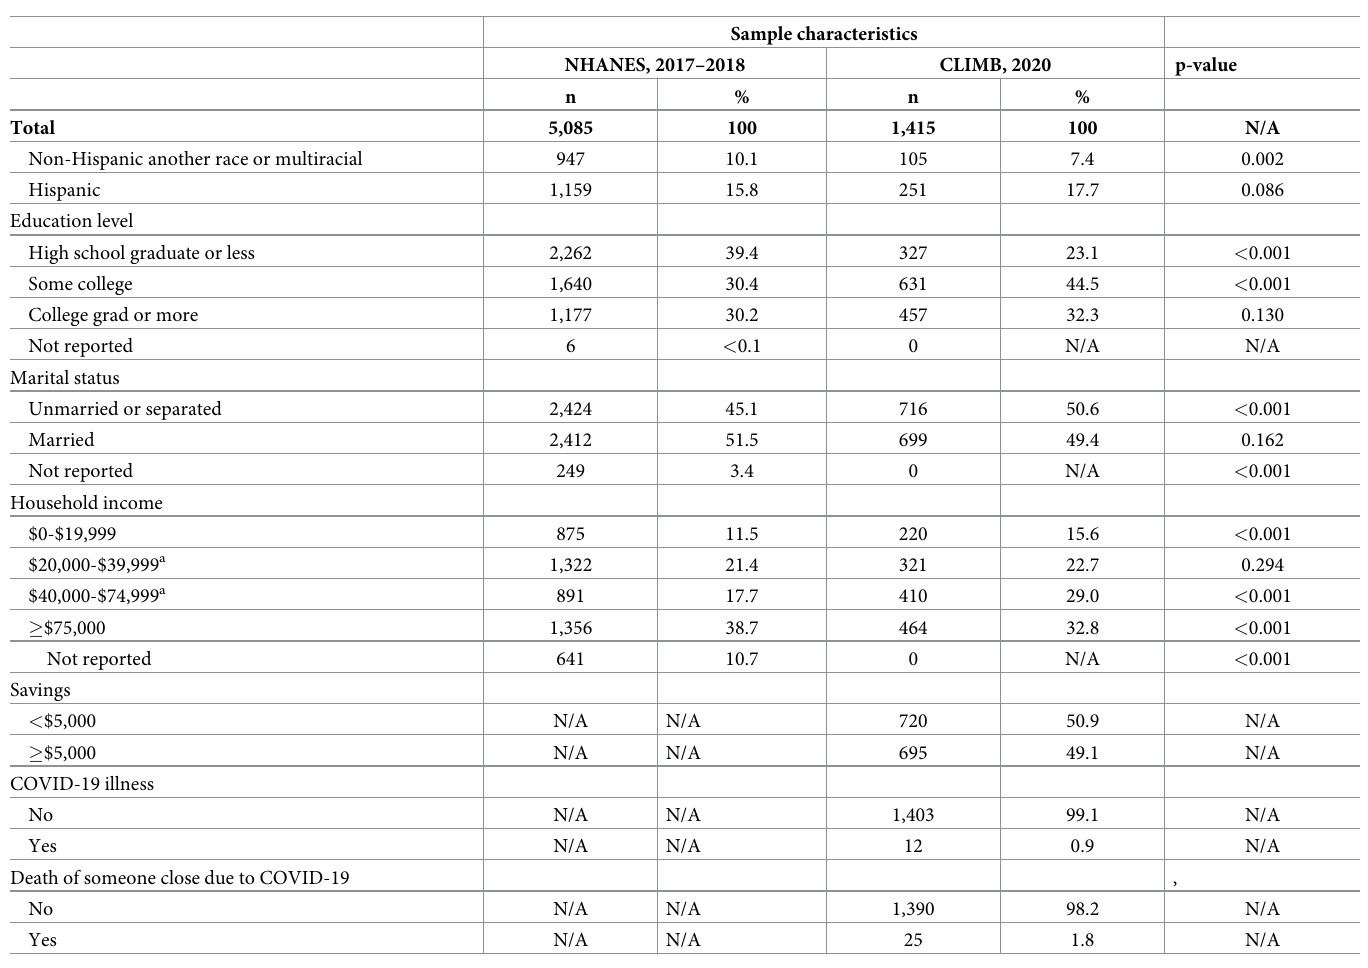
The prevalence of suicidal ideation was 3.4% in the 2017–2018 NHANES sample and 16.3% in the 2020 CLIMB survey (Table 2). The greatest absolute increases in suicidal ideation and 2020 prevalence of suicidal ideation were among participants earning less than $20,000 (5.8% to 26.4%), participants aged 18 to 29 (4.1% to 23.5%), and participants who were Hispanic (3.7% to 23.1%). In 2020, suicidal ideation was high among those who faced difficulty paying rent (31.5%, Fig 1) and job loss (24.1%), as well as loneliness (25.1%). Each of the stressors we evaluated were associated with suicidal ideation in the bivariable model (Table 3; Difficulty paying rent PR: 2.3, 95% CI: 1.8 to 3.1; feeling alone PR: 2.1, 95% CI: 1.6 to 2.6; job loss PR: 1.6, 95% CI: 1.1 to 2.2). In the multivariable model, difficulty paying rent was associated with suicidal ideation (aPR: 1.5, 95% CI: 1.2 to 2.1), while losing a job was not (aPR: 0.9, 95% CI: 0.6 to 1.2). The sensitivity analysis with job loss as the exposure without difficulty paying rent in the model did not change the effect estimate. Feeling alone was also associated with suicidal ideation (aPR: 1.9, 95% CI: 1.5 to 2.4). Although the sample size for persons with COVID-19 illness (n = 12) or bereavement (n = 25) is small, the results